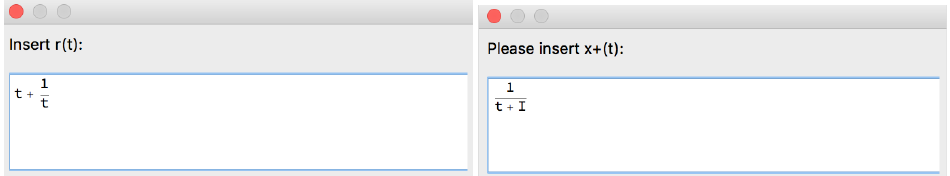
Figure 58. Part of the structure of the [SInt] 2.0 algorithm responsible for the input options.